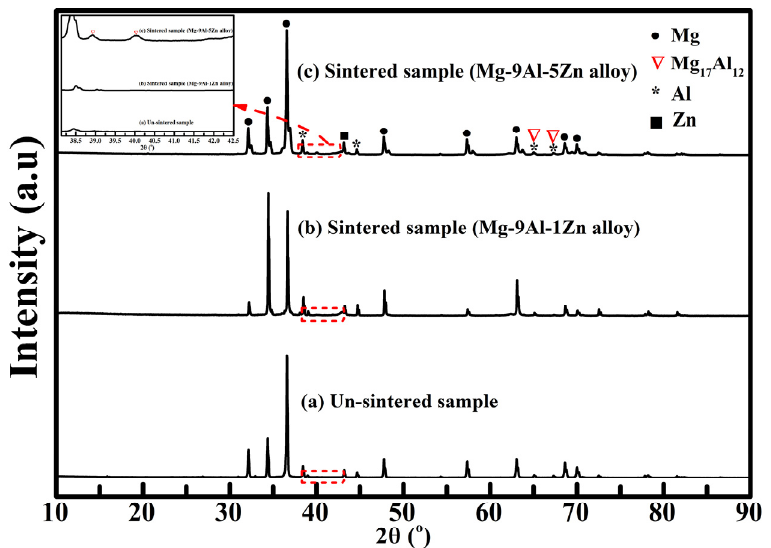
Figure 4. X-ray diffraction patterns of the cell walls of porous Mg-Al-Zn foam samples before and after sintering.